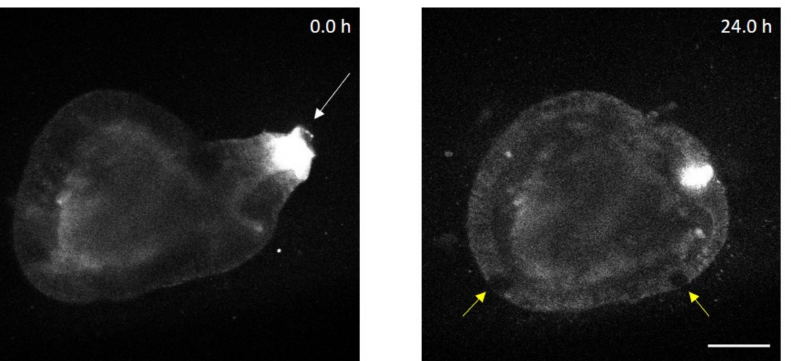
Figure A1. Two-photon microscopy of a colonoid that failed to repair single-cell ablation. The white arrow shows the ablation site, which has not resealed over time, even after 24 h. The cell layer of the colonoid shows gaps (yellow arrows) and no intact integrity. Scale bar 50 µ m.